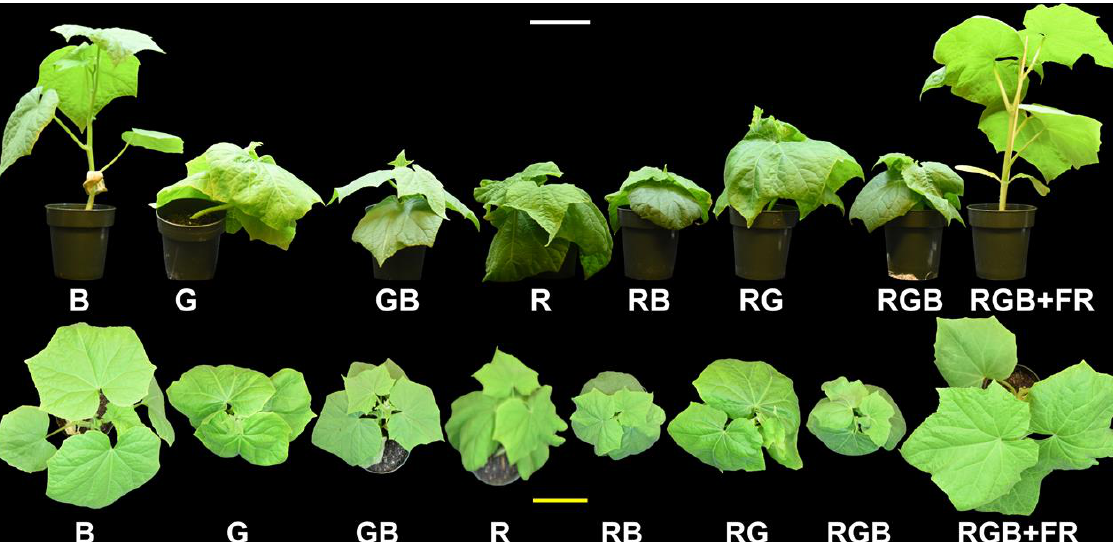
Figure 3. Profile and overhead images of representative plants, chosen by selecting the plant that was closest in dry weight and height to the treatment average. This image is a composite to allow for visual comparison between treatments. Cucumber seedlings were grown under blue (B), green (G), green–blue (GB), red (R), red–blue (RB), red–green (RG), red–green–blue (RGB), and red–green–blue with far-red (RGB + FR) light. The white bar in the upper middle is 10 cm for profile images, while the yellow bar in the lower middle is 10 cm for overhead images.